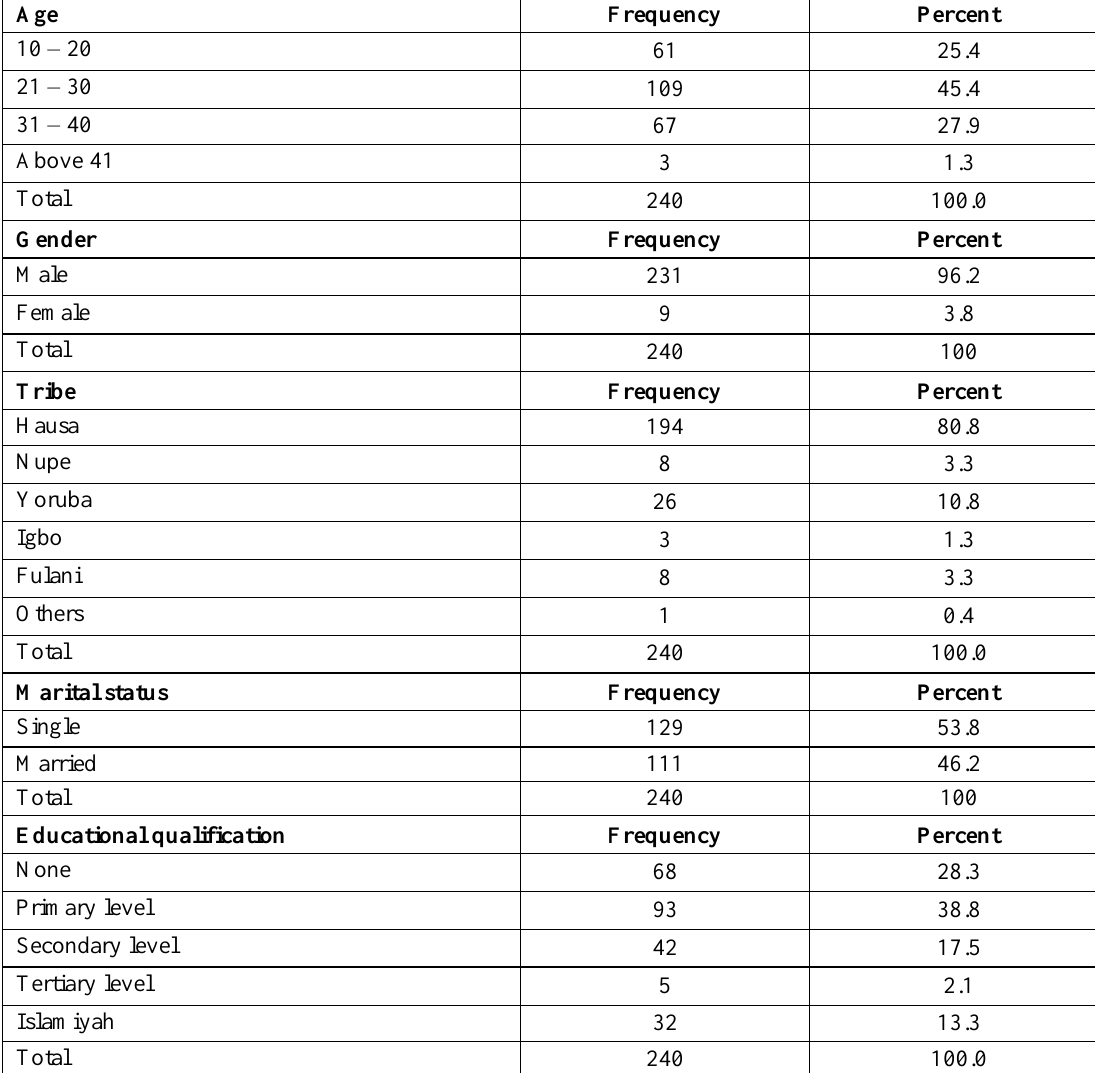
Table 1. Socio-demographic characteristics of